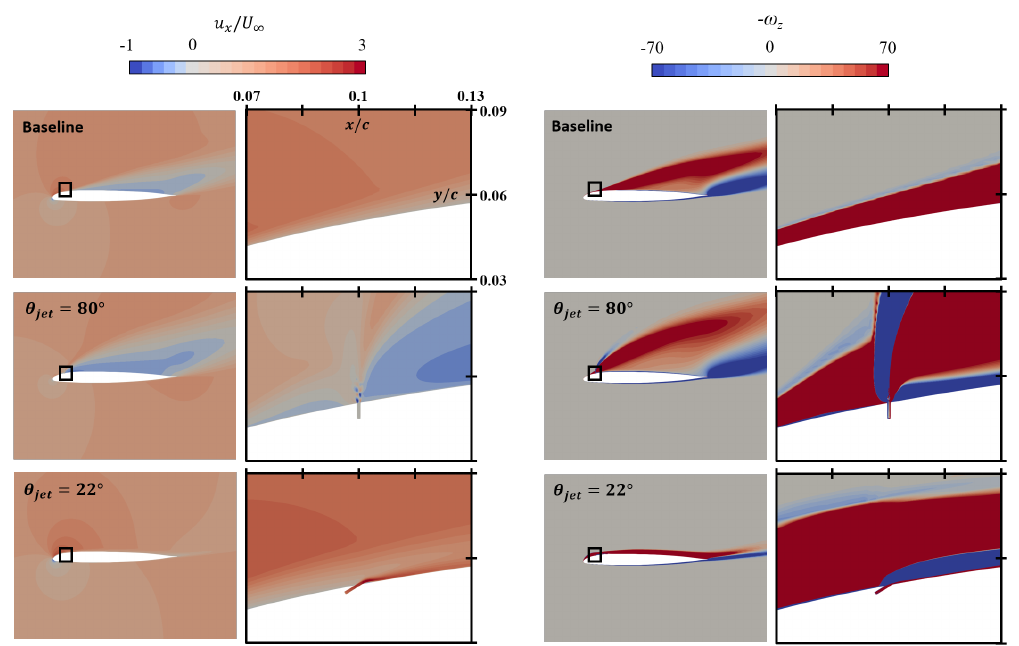
Figure 9. Time-averaged flow field around the OA209 airfoil with and without steady-blowing jets. Ma = 0.3, Re = 1.15 M, c µ = 0.06 and α = 17 ◦